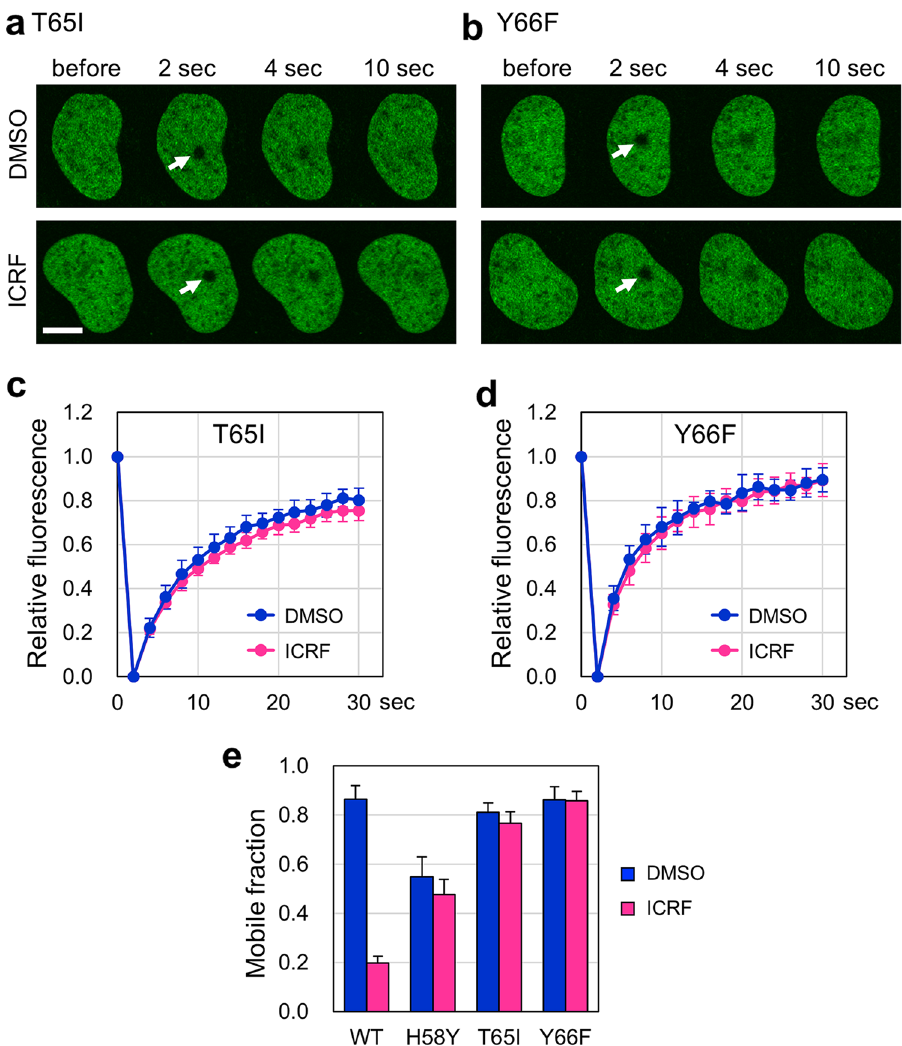
Figure 4. High nuclear mobility of ICRF-resistant T65I and Y66F proteins. ( a,b ) Representative images of FRAP analysis of EGFP-TOP2B T65I and Y66F in the presence of ICRF-187. Experiments were performed as described in Fig. 3a. ( c ) Quantitative analysis of fluorescence recovery of EGFP-TOP2B T65I in the presence and absence of 20 µM ICRF-187 (n = 10; bars, SD). The mobile fractions were estimated to be 0.81 ± 0.04 (DMSO) and 0.77 ± 0.05 (ICRF). The t1/2 of fluorescence recovery was calculated to be 5.36 ± 0.98 s (DMSO) and 5.66 ± 1.01 s (ICRF). ( d ) Quantitative analysis of fluorescence recovery of EGFP-TOP2B Y66F in the presence and absence of 20 µM ICRF-187 (n = 10; bars, SD). The mobile fractions were estimated to be 0.86 ± 0.05 (DMSO) and 0.86 ± 0.04 (ICRF). The t1/2 of fluorescence recovery was calculated to be 3.58 ± 0.87 s (DMSO) and 3.91 ± 0.60 s (ICRF). ( e ) Comparison of the mobile fractions. The graph represents the mobile fractions shown in Fig. 3c (WT), Fig. 3d (H58Y), ( c ) (T65I), and ( d ) (Y66F) (n = 10; bars, SD). Statistical values between DMSO and ICRF treatments are as follows; WT: p = 1.41E−14, H58Y: p = 0.043, T65I: p = 0.031, Y66F: p =